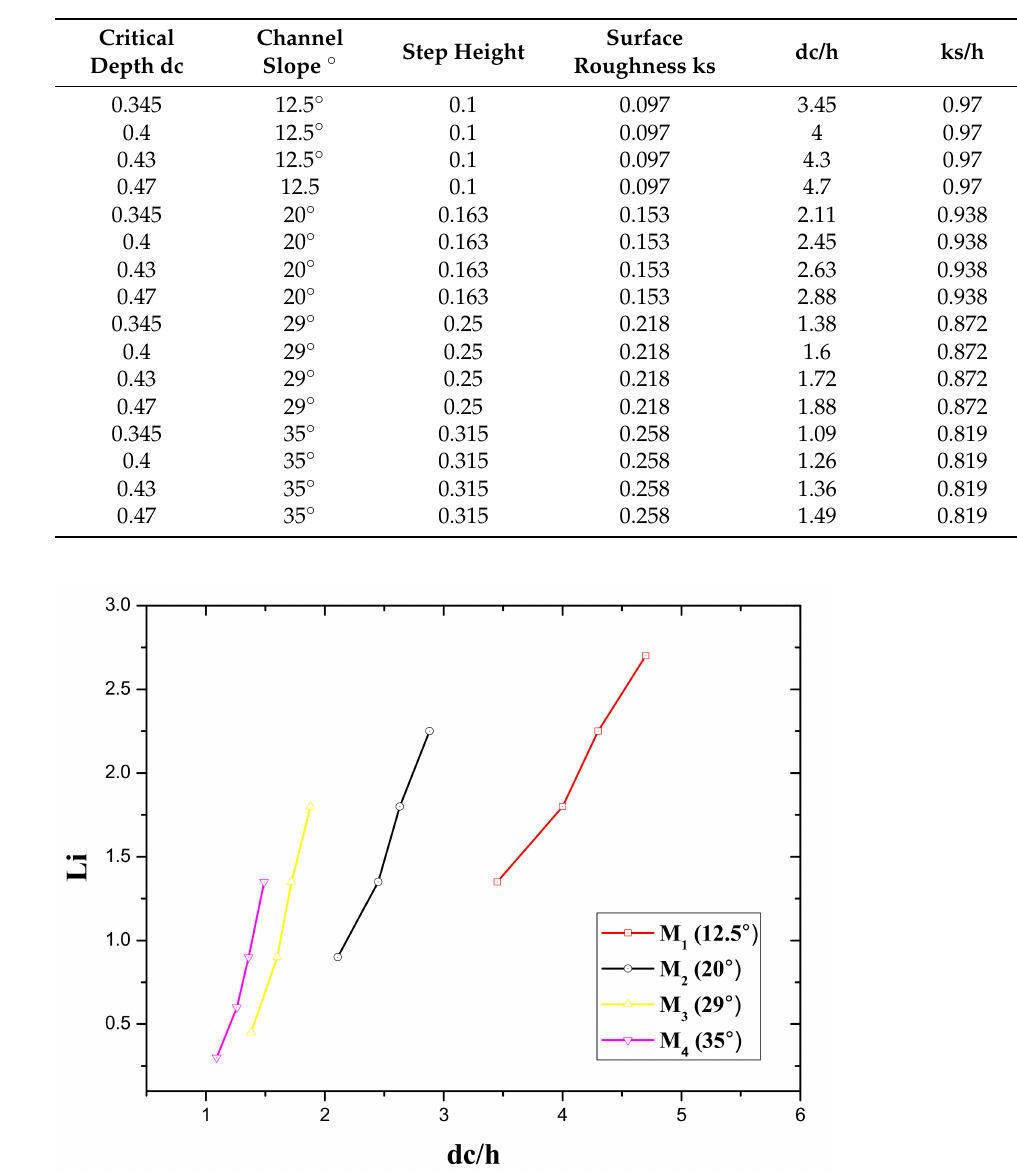
Table 3. Summary of critical depth (dc), relative critical depth (dc/h), and ks/h for 12.5 ◦ , 20 ◦ , 29 ◦ .